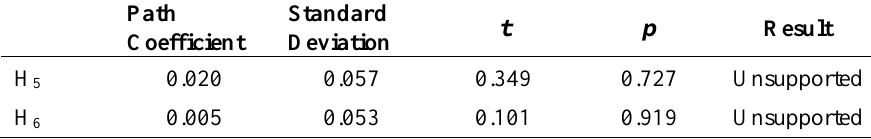
Table 4: Results of Secondary